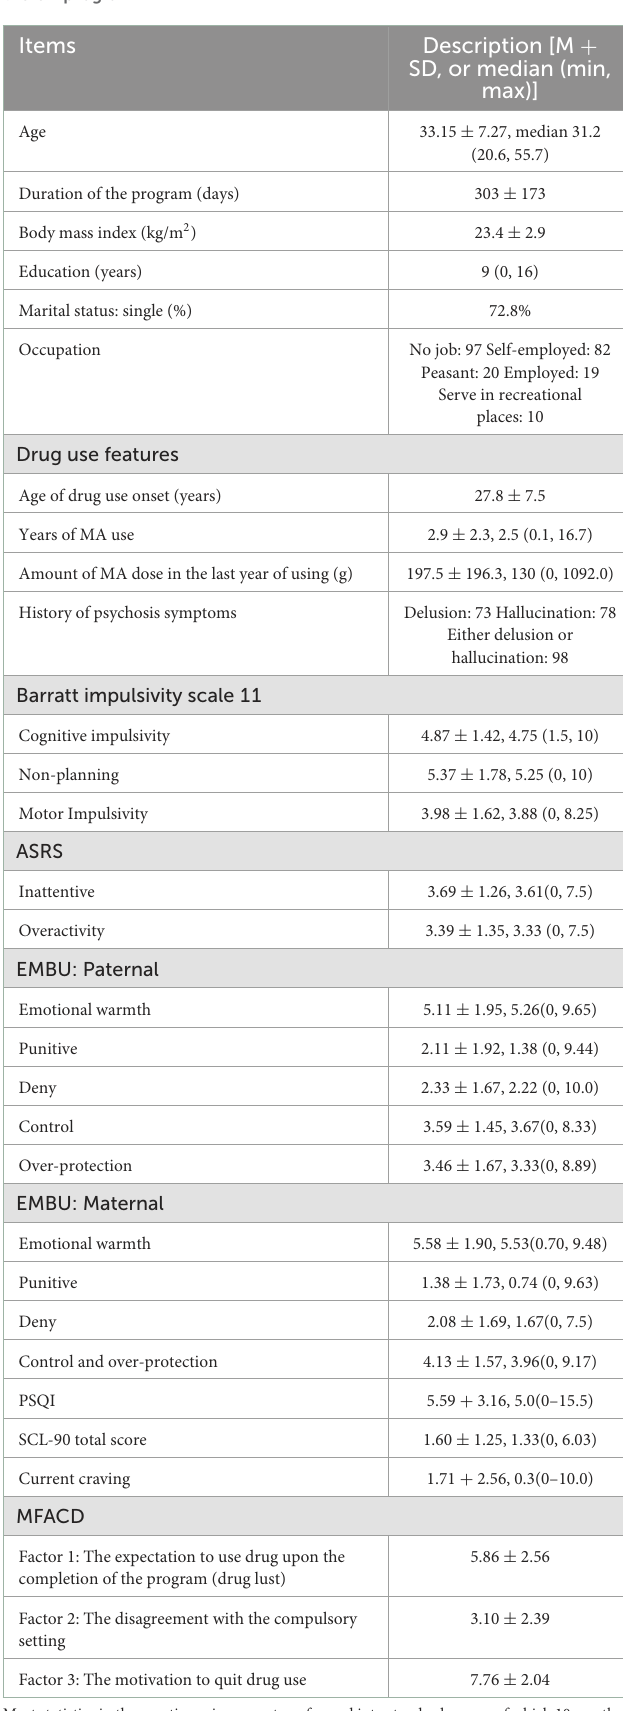
TABLE 1 General information on the 228 male methamphetamine users in the CD program.